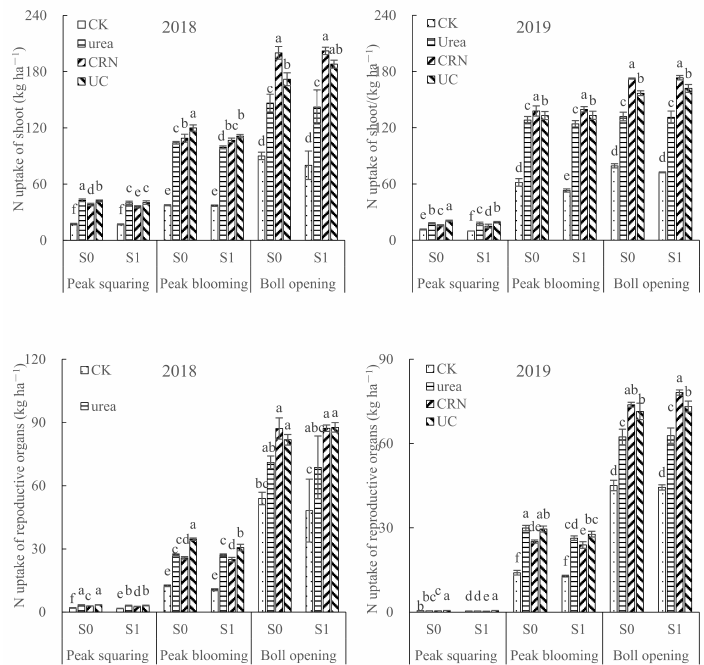
Figure 2. Effects of straw management combined with N-fertilization strategy on N uptake at main growth stages in field-seeded cotton. The data are the means for three replications ± SD. Different letters on the bar mean significant difference at the 0.05 level. S0, straw removal; S1, straw returning; CRN, controlled-release N fertilizer; UC, the mixture of urea and